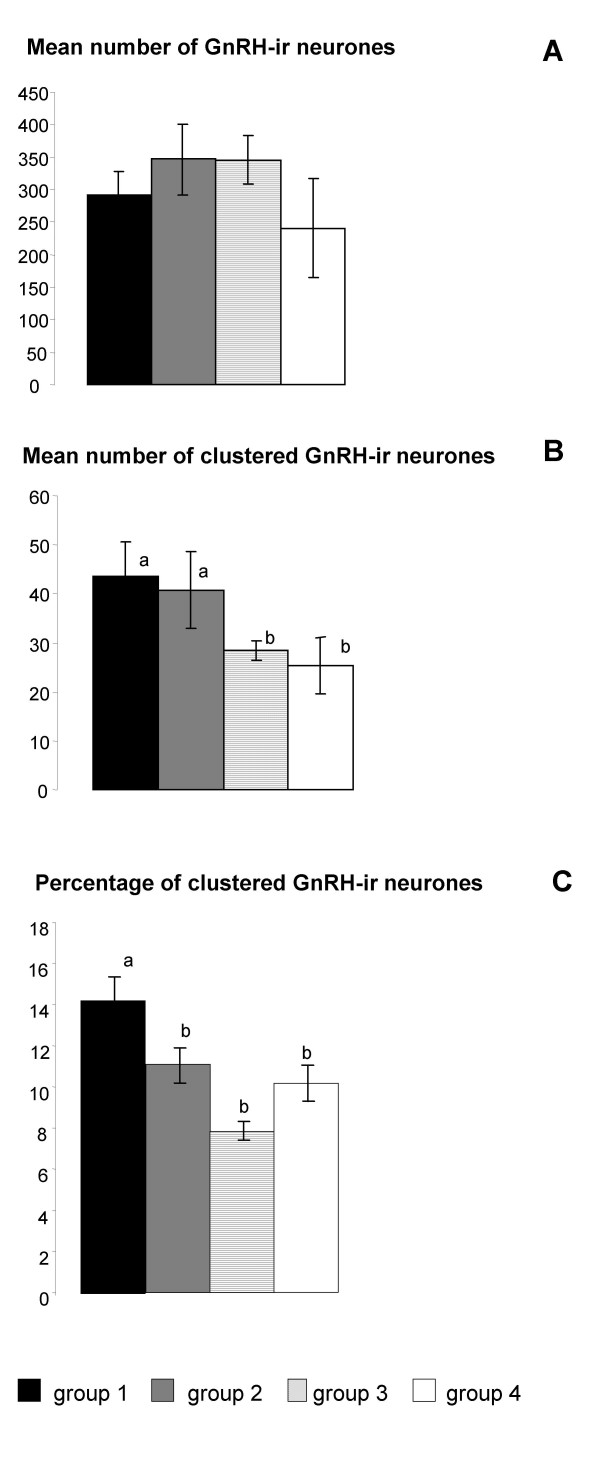
Mean number (±SEM) of single (A), clustered (B) and percentage of clusters (C) of GnRH-immunoreactive neurons counted in the preoptic area of ewes in the four experimental groups of the first experiment. Different letters indicate significant differences (p < 0.05). On histogram B, groups 1 and 2, like groups 3 and 4, are not statistically different, but groups 1 and 2, and groups 3 and 4, are statistically different; on histogram C group 1 is statistically higher than the other groups.